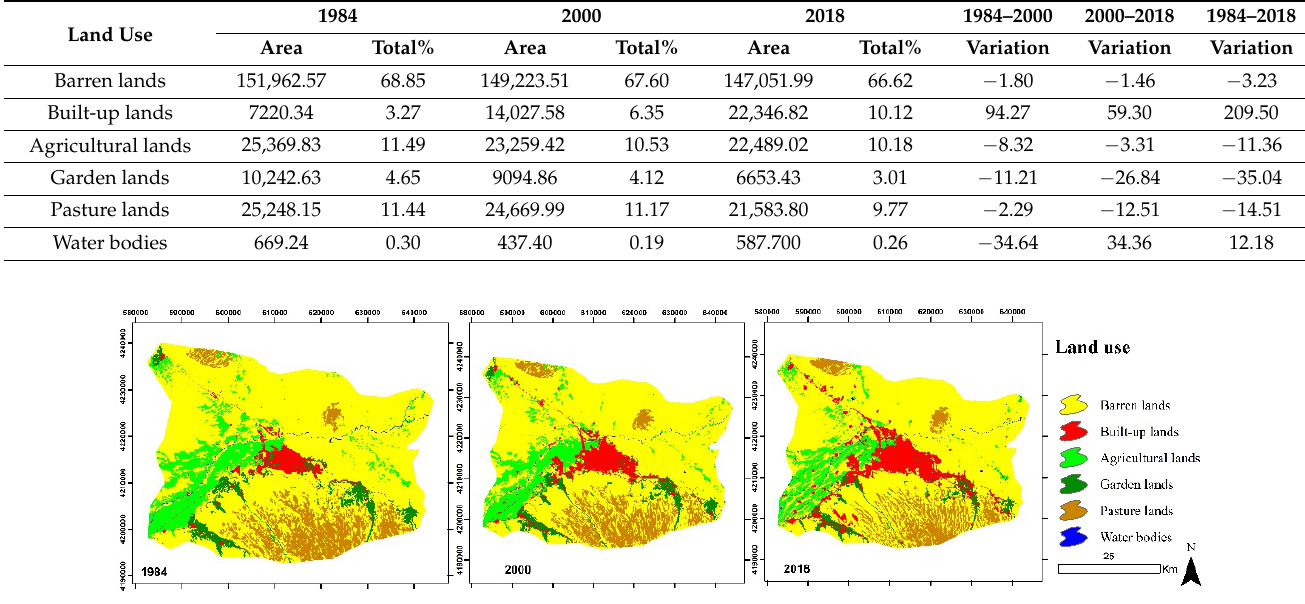
Figure 2. Flow chart of the presented